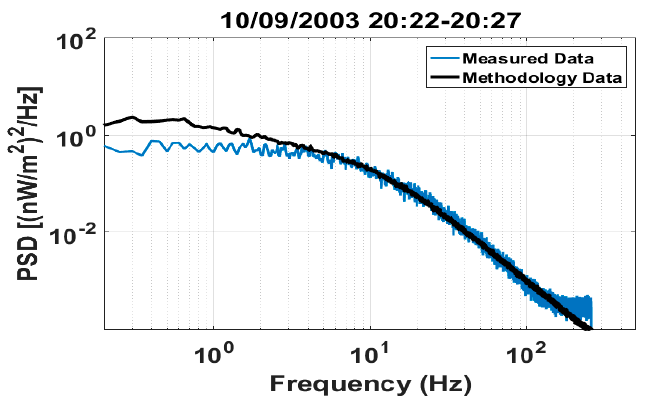
Figure 9. Second order irradiance statistics validation for session on 10/09/2003 20:10. PSD of measured data vs. PSD of generated data.